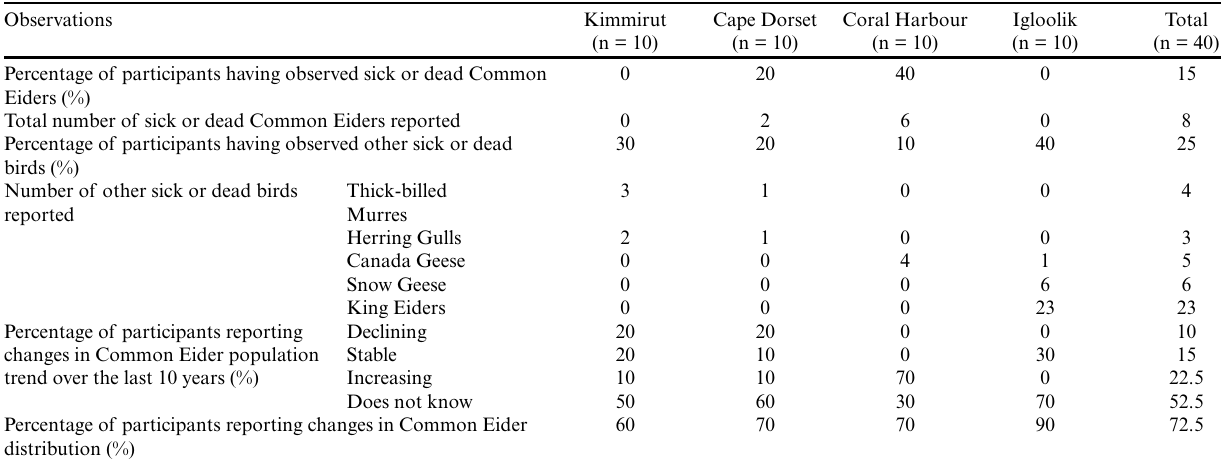
Table 3 . Observations of disease and mortality events, population trends, and distributional changes among Common Eiders ( Somateria mollissima ) and other birds as reported by participants in Kimmirut, Cape Dorset, Coral Harbour, and Igloolik, Nunavut. Observations Kimmirut